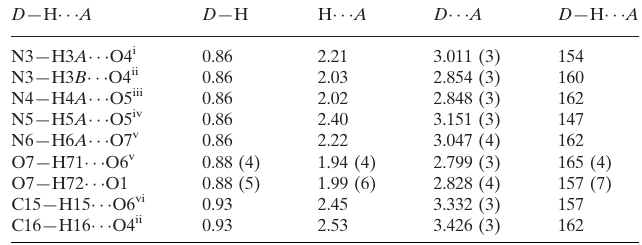
Hydrogen-bond geometry (A˚ , (cid:3)